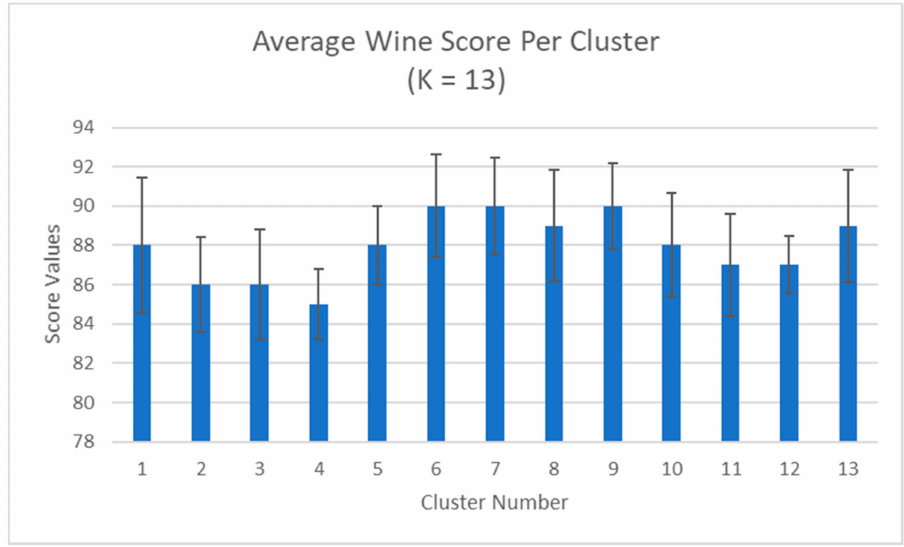
Figure 14. Average wine scores ( ± SD) per cluster when K = 13. The average wine scores of the clusters decreased overall. This can be attributed to the increased number of wines in each cluster as there exists a larger variation in scores for each